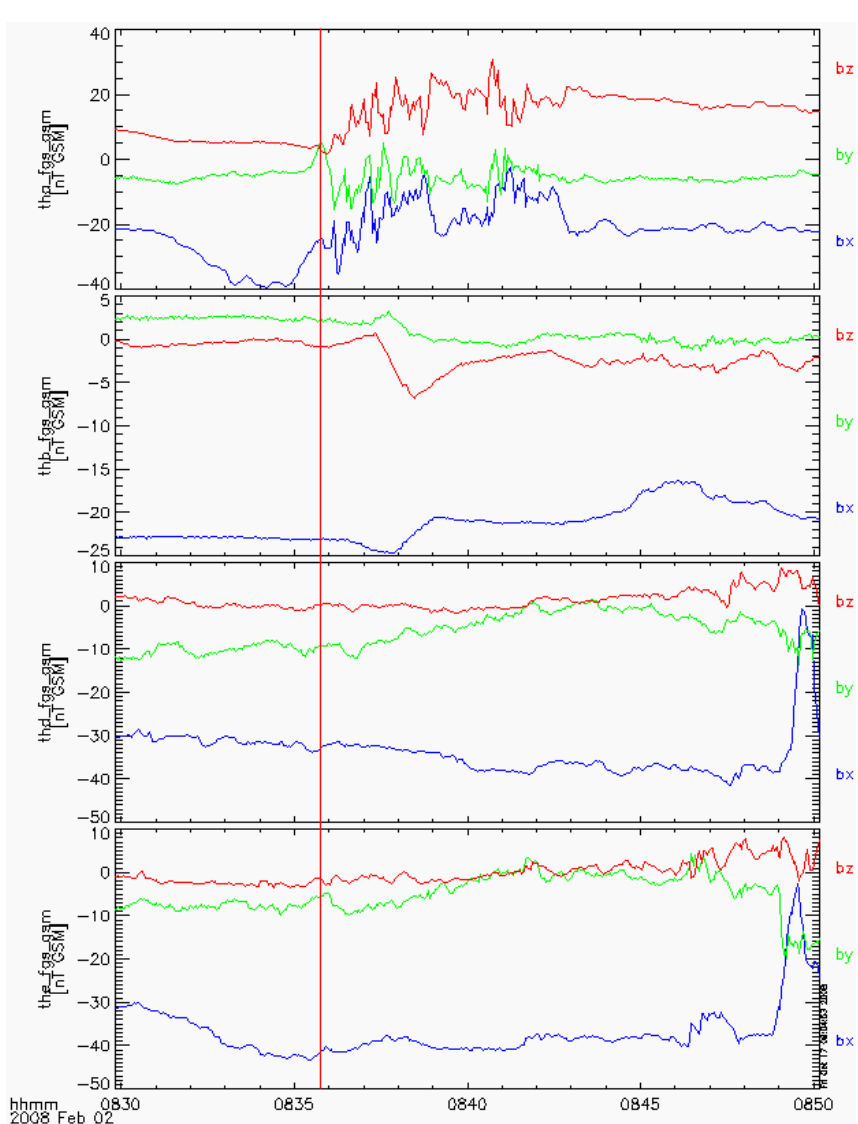
Fig. 18. THEMIS A, B, D, and E magnetometer plots. The ground onset of the expansion phase is illustrated with red vertical straight line.